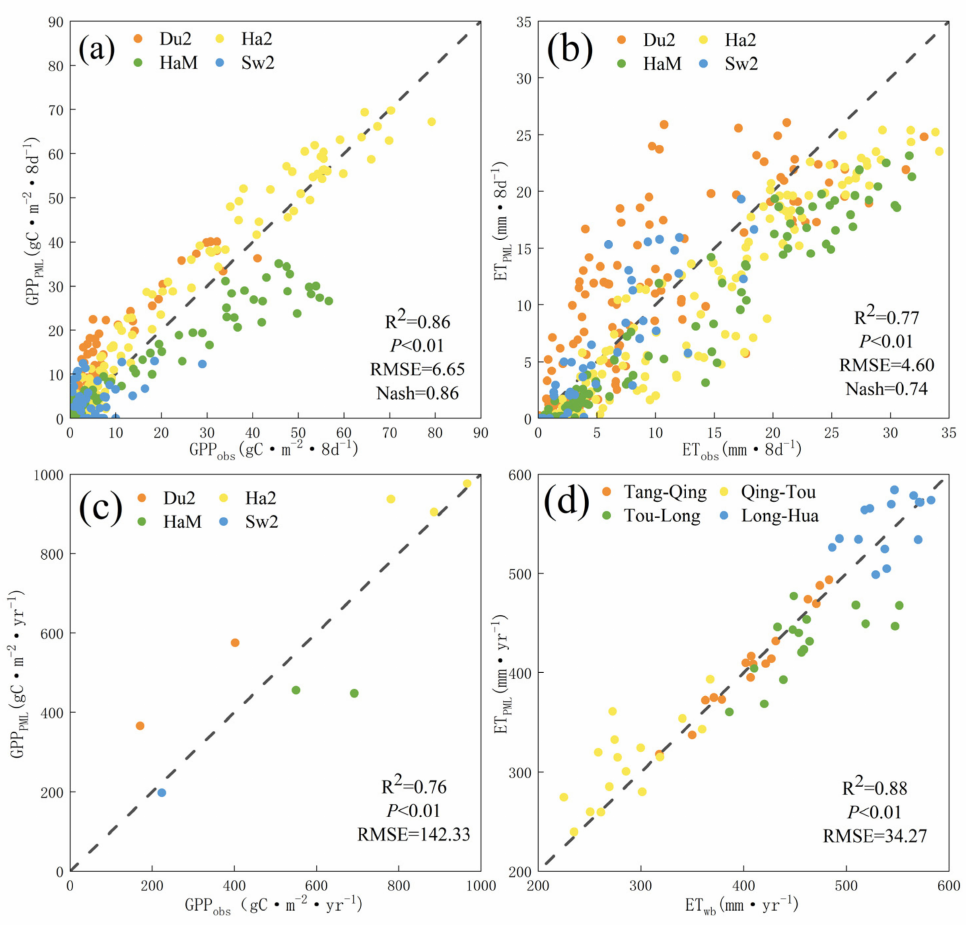
Figure 2. ( a – c ) Validation of PML_V2 based on observations from four flux stations and ( d ) water balance over four sub-regions in the Yellow River